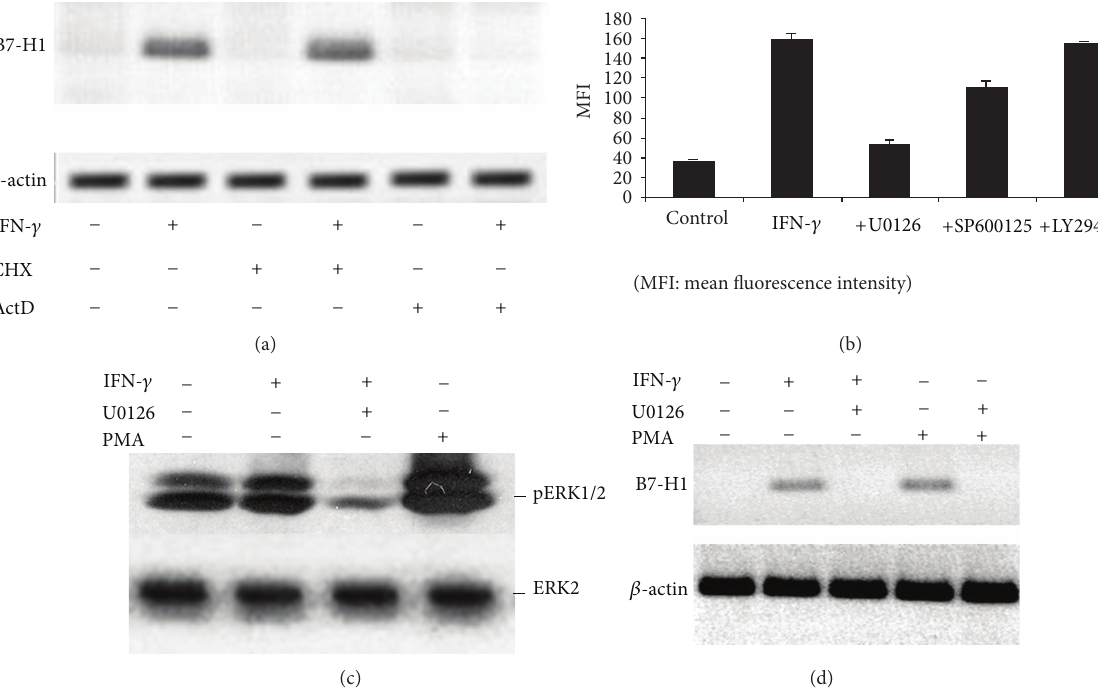
Figure 2: MEK/ERK-dependent B7-H1 expression in HSCs. (a) B7-H1 mRNA levels in HSCs measured by RT-PCR after exposure to IFN- 𝛾 (10U/mL) for 6 hours with or without 10 𝜇 g/mL CHX or 10 𝜇 g/mL ActD for 90 minutes. (b) Flow cytometric analysis of B7-H1 expression in control HSCs (without IFN- 𝛾 stimulation) and after 24 hours incubation with IFN- 𝛾 with or without 1 hour pretreatment with signal transduction inhibitors, that is, 100 𝜇 M U0126 (MEK1/2), 100 𝜇 M SP600125 (JNK), and 100 𝜇 M LY294002 (PI3K). (c) Western blot analysis of ERK1/2 phosphorylation in HSCs after incubation with IFN- 𝛾 (10U/mL) or 1ng/mL PMA, with or without 1 hour preincubation with 100 𝜇 M U0126. (d) RT-PCR analysis of B7-H1 mRNA levels in HSCs exposed for 24 hours to IFN- 𝛾 (10U/mL) or 1ng/mL PMA with or without 1 hour pre-incubation with 100 𝜇 M